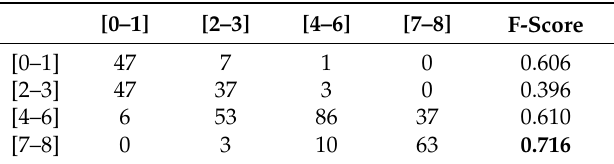
Table 2. Confusion Matrix of Automatic Classification Based on Allred Score with Expert-2. The best F-score value is presented in